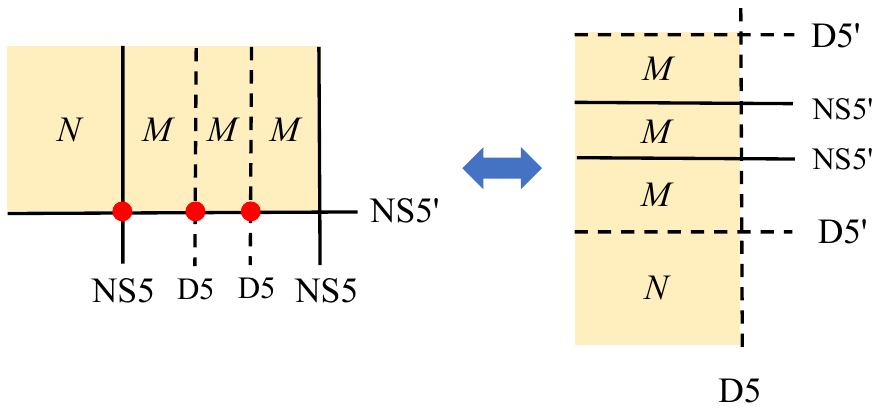
3d ( M ) [2] with Neumann b.c. | − or Nahm pole b.c. for D